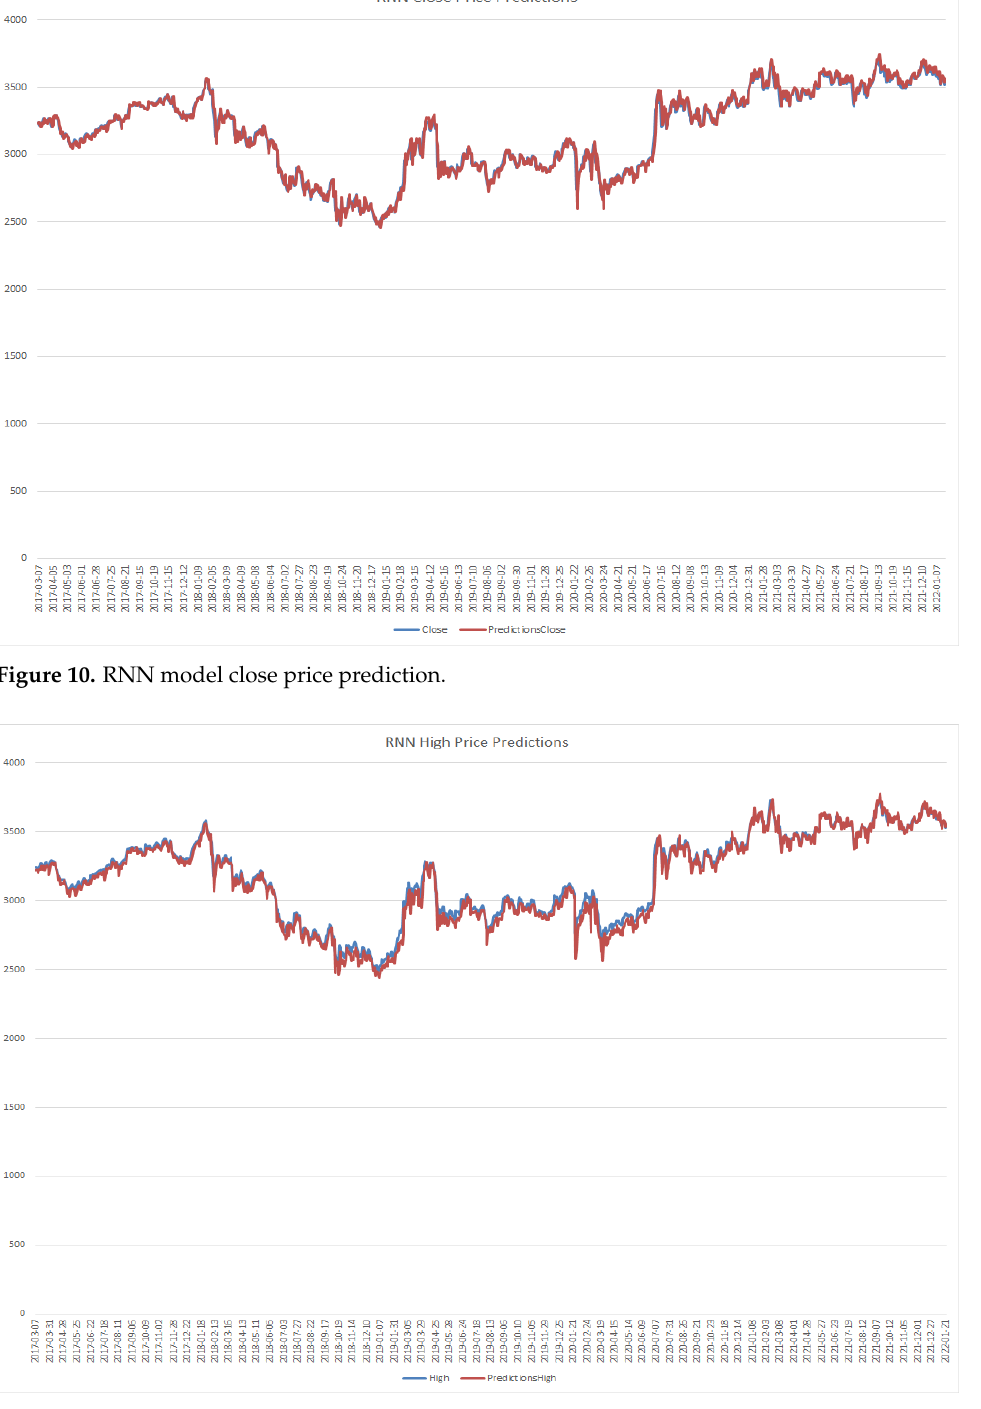
Figure 11. RNN model high price